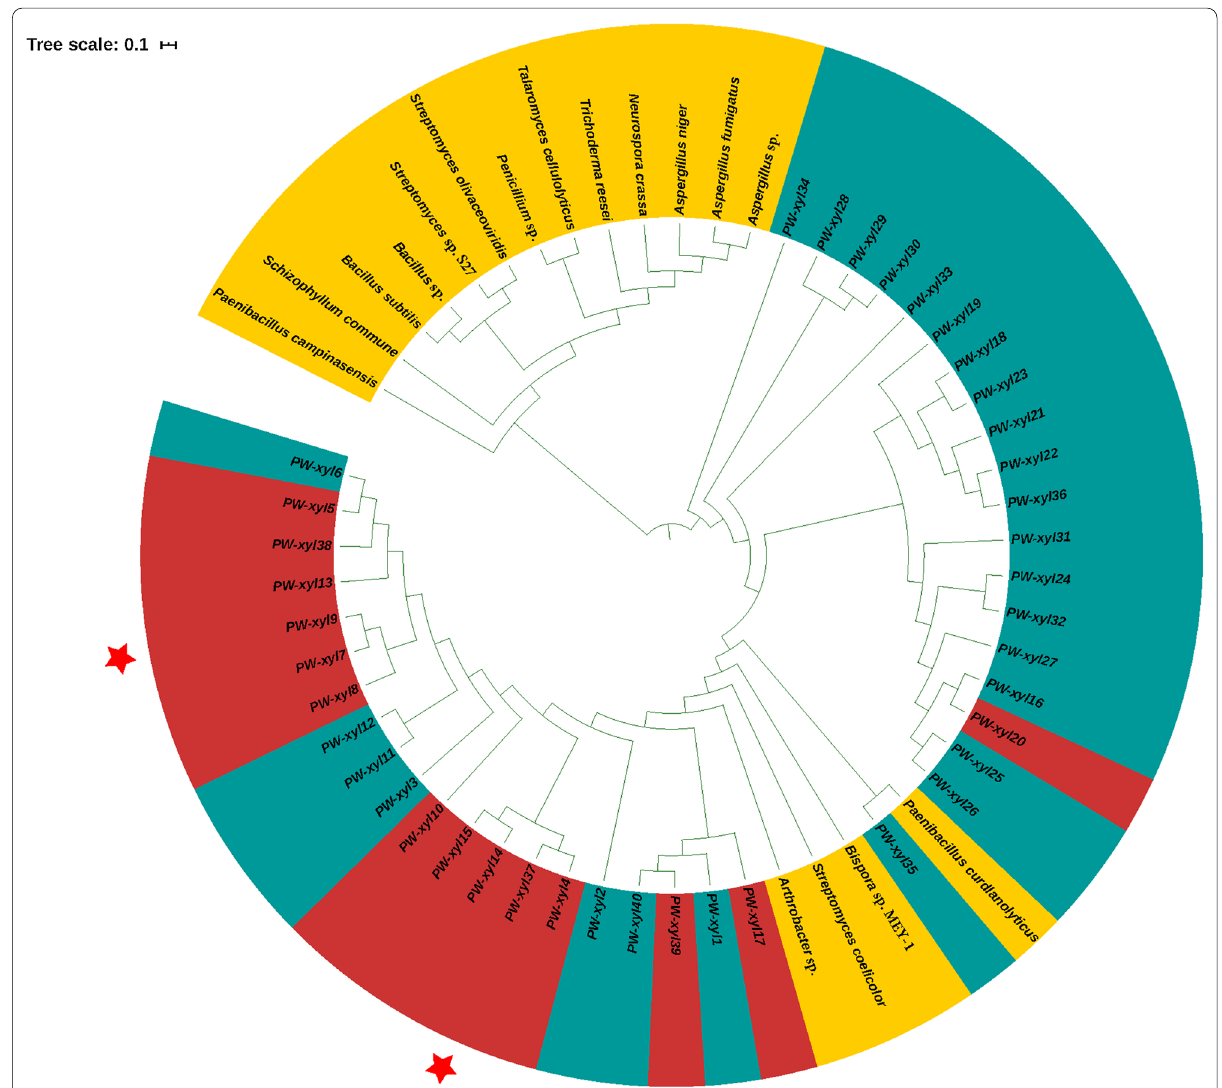
Fig. 1 The phylogenetic tree of the 40 verified xylanase genes and some xylanase genes downloaded from available database based on amino acid identity analyses with MEGA. The genes labeled yellow are xylanases with high activity retrieved from the enzyme repository of the ExPaSy database accessed at https ://enzym e.expas y.org/. The microbial gene sources and their accession numbers are: Aspergillus niger XP_001388522.1, Bispora sp. MEY-1 ACS96449.1, Penicillium sp. ACY70400.1, Schizophyllum commune P35809.1, Talaromyces cellulolyticus BAO51921.1, Trichoderma reesei ACB38137.1, Aspergillus sp. Q4WG11.1, Neurospora crassa Q7SDQ1, Streptomyces coelicolor NP_733679.1, Bacillus subtilis P18429, Streptomyces sp. S27 ACF57948.1, Paenibacillus campinasensis Q2I6W5, Paenibacillus curdlanolyticus BAK22544.1, Bacillus sp. ACR47980.1, Arthrobacter sp. AGC01501.1, Streptomyces olivaceoviridis AHK22787.1. The 40 gene sequences with blue and red markings were expressed in E. coli ; the ones marked red were expressed with xylanase activity, whereas the ones marked blue were expressed without xylanase activity. The two proteins labeled with two red star pentagons were selected to determine their xylanase properties after